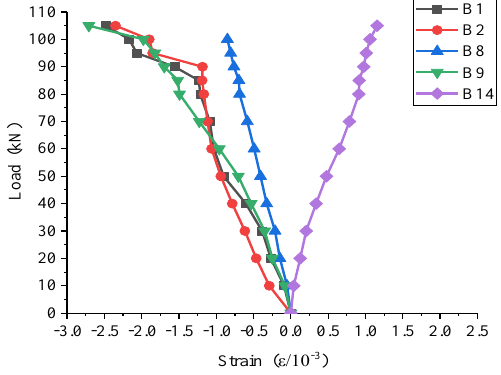
Figure 19. Load–strain curve of S1, area B.